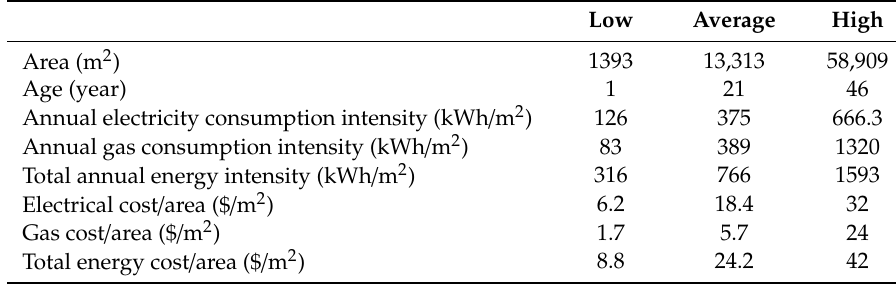
Table 6. Annual energy data for Texas hospitals.